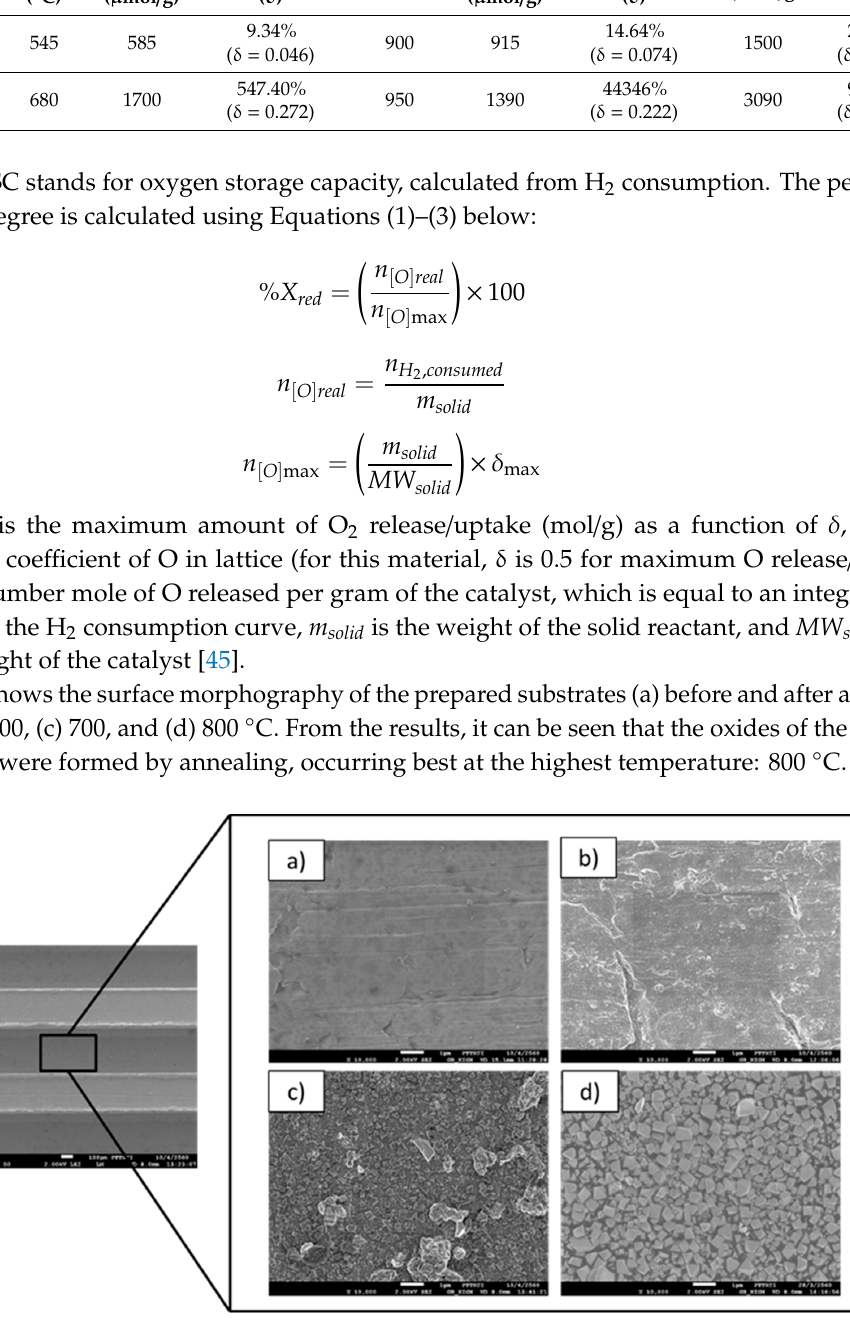
Figure 5. Morphology of the substrate surface analyzed using SEM technique: ( a ) before annealing and after annealing process at ( b ) 600, ( c ) 700, and ( d ) 800 °C.